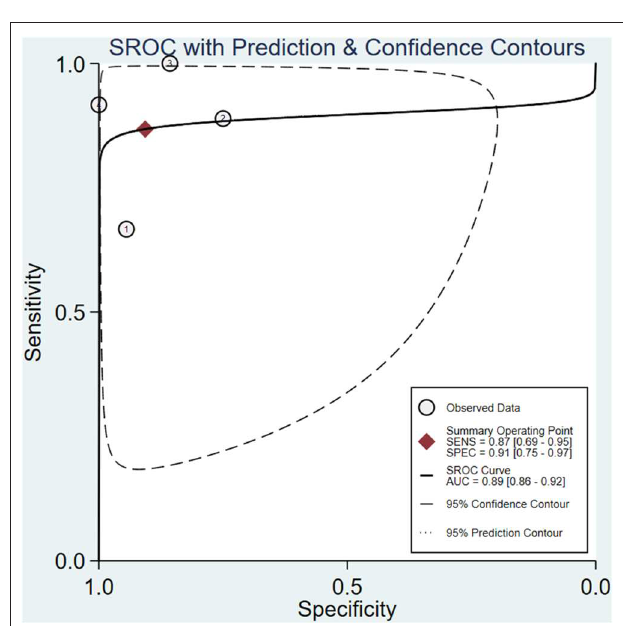
FIGURE 6 | Summary receiver operating characteristic plot for the washout rate of 99m Tc-MIBI scintigraphy in preoperatively assessing the response of osteosarcoma patients to neoadjuvant